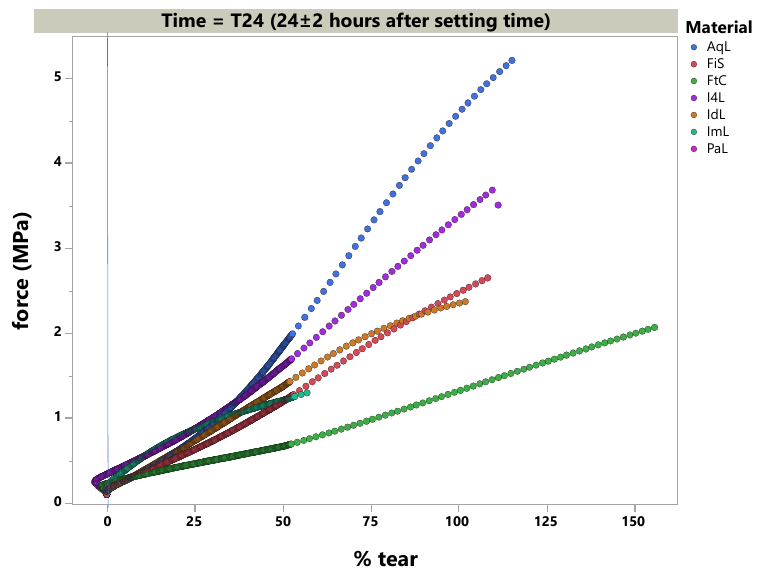
Figure 8. Stress–strain diagram of the light-body materials 24 h after impression taking (T24).